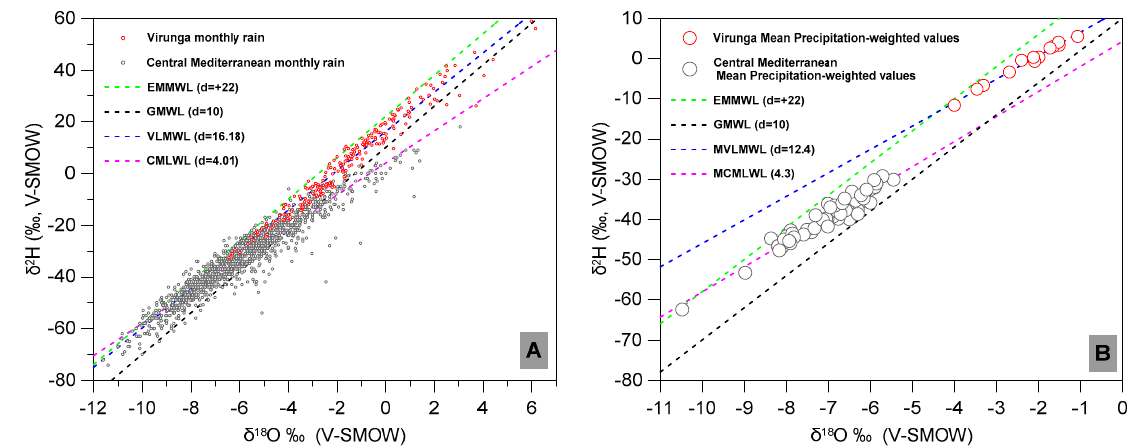
Figure 2. Relationship between δ 2 H and δ 18 O in monthly rainwater from the Virunga region, located on the limit between Central and Eastern Africa, within the western branch of the East African Rift System, and the Central Mediterranean (Stromboli and Sicily Islands, Italy). In ( A ) and ( B ), EMMWL refers to the Eastern Mediterranean Meteoric Water Line after Gat and Carmi [13], and GMWL to the Global Meteoric Water Line after Craig [6]. In ( A ) the Virunga Local Meteoric Water Line (VLMW), and the Central Mediterranean Local Meteoric Water Line (CMLWL) are plotted; both lines were obtained using monthly values. In ( B ), the Mean Virunga Local Meteoric Water Line (MVLMWL) and Mean Central Mediterranean Local Meteoric Water Line (CMLWL) are plotted, and both were obtained using mean precipitation-weighted values.